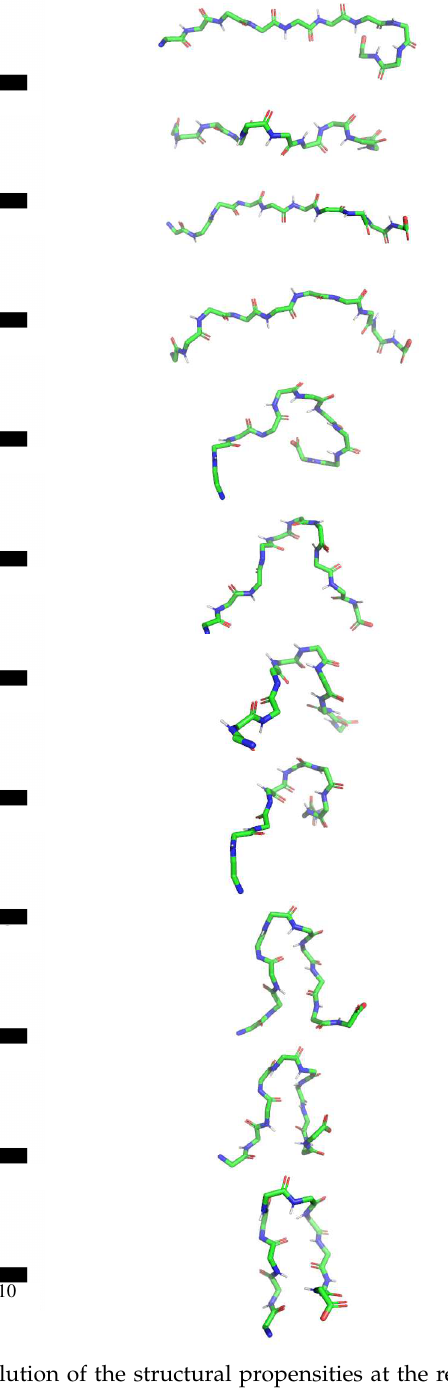
Figure 3. The left side panel represents the evolution of the structural propensities at the residue level along Chignolin folding pathway (see Figure 1 and the associated comments for additional explanations about this representation). The right side panel shows some intermediate states along one of the computed folding paths. Only the protein backbone is represented, using PyMOL